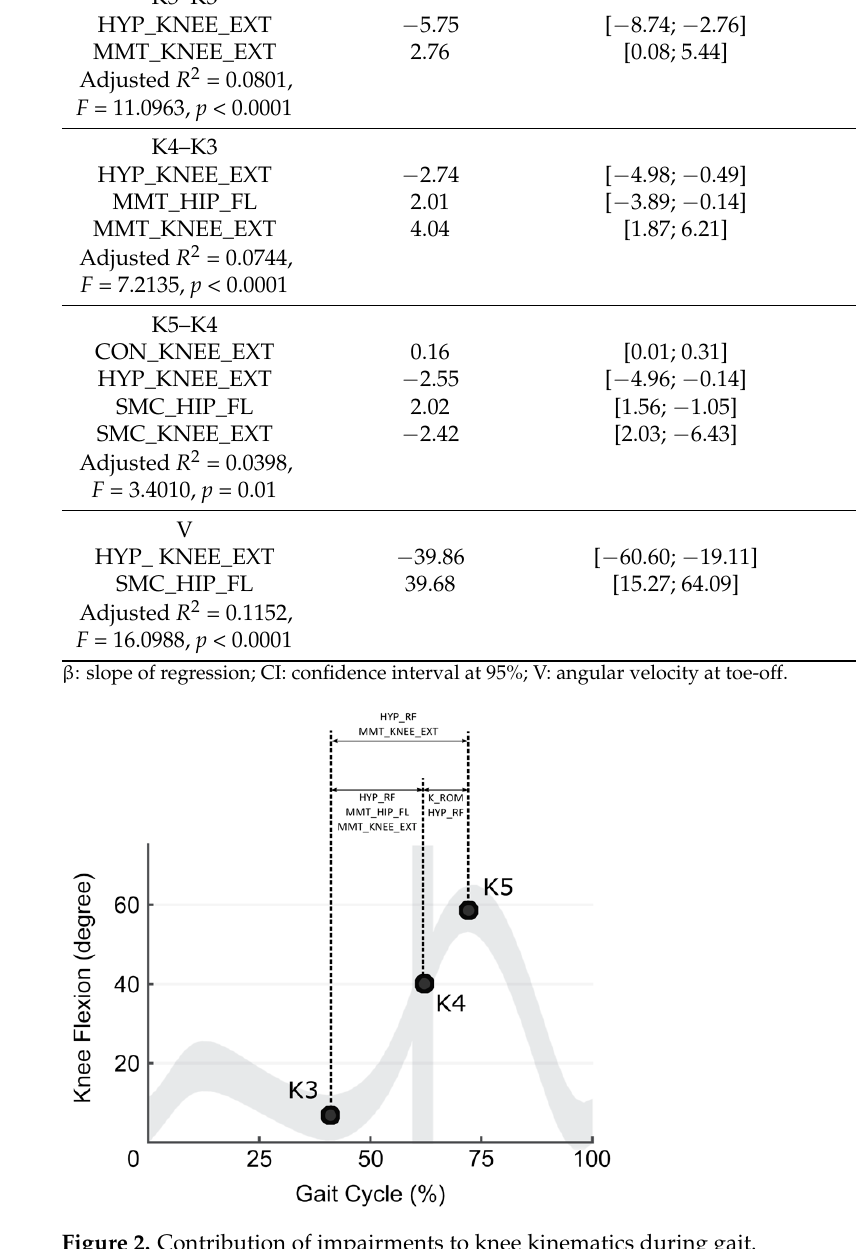
Figure 2. Contribution of impairments to knee kinematics during gait. Table 2. Multiple linear regression analysis with selected knee ROM and angular velocity at toe-off as independent variables ( n = 262).